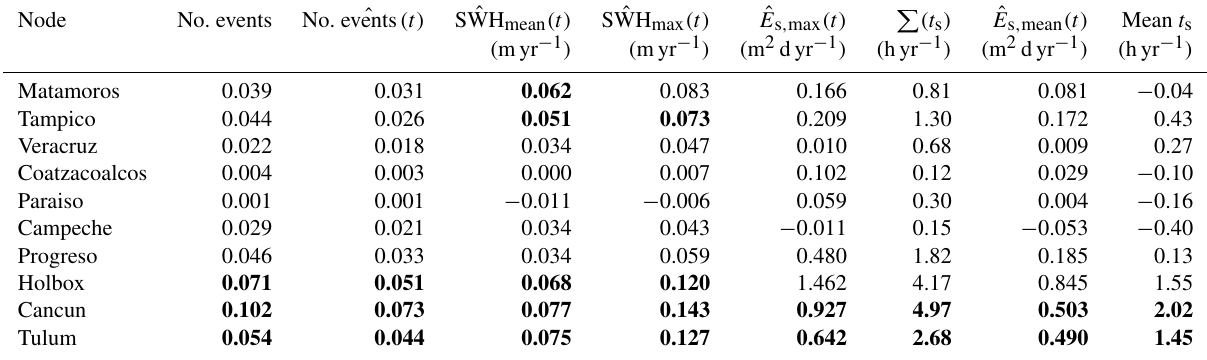
− 0.001 Cancun Tulum 0.022 − 0.23 Table 3. Trends found in the number of TC events, estimated number of TC, estimated SWH mean and estimated SWH max , estimated E s , mean , total t s , estimated E s , max and mean t s per season. Bold font indicates that the presence of a trend is confirmed by the Mann–Kendall test at the 90% confidence